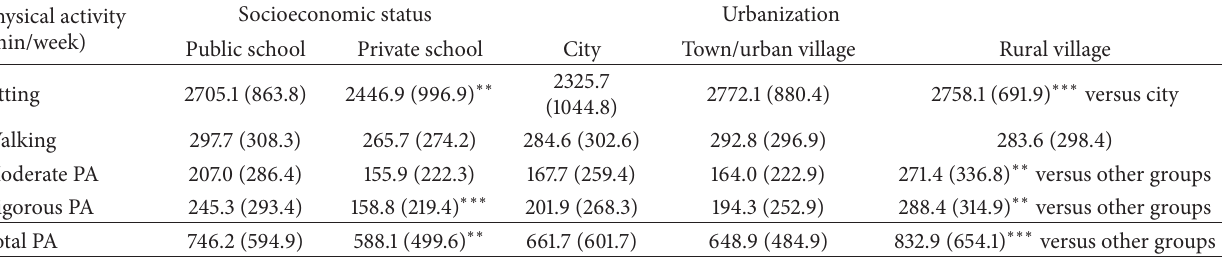
Table 2: Physical activity by socioeconomic status and urbanization.